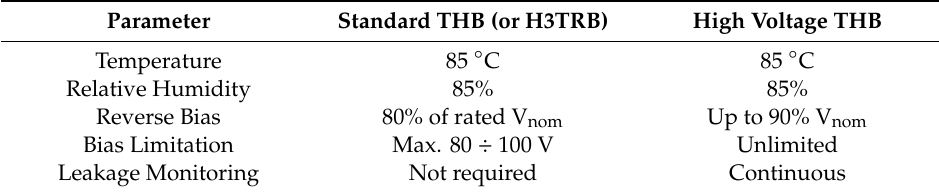
Table 1. Generic stress parameters of standard versus high-voltage Temperature Humidity Bias (THB) test. The HV-THB is not limited in voltage, while the standard H3TRB has a maximum reverse bias voltage of 100